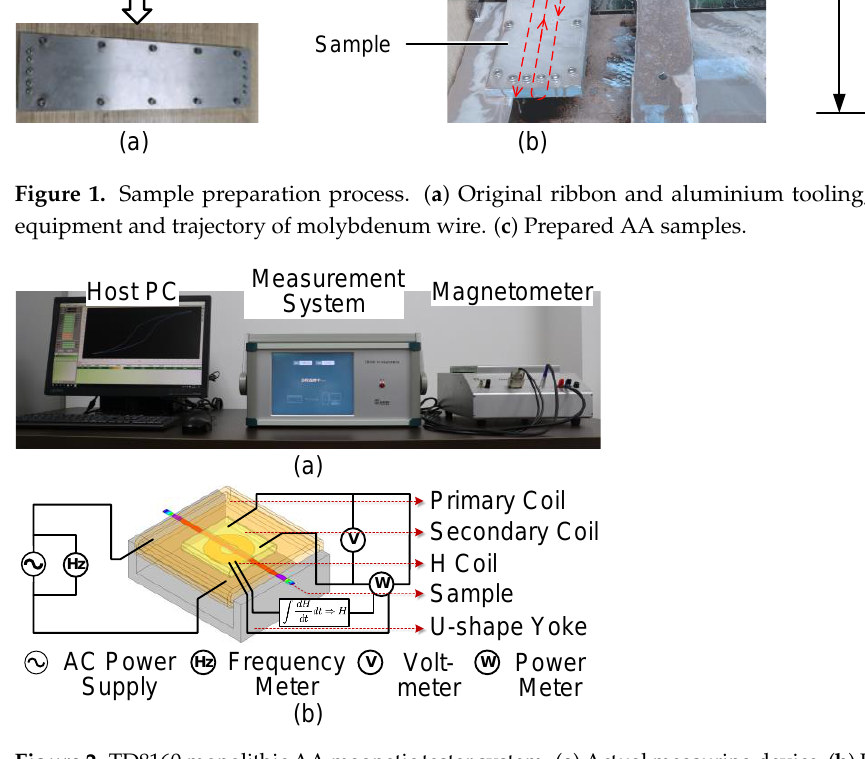
Figure 2. TD8160 monolithic AA magnetic tester system. ( a ) Actual measuring device, ( b ) Basic structure of magnetometer and measurement